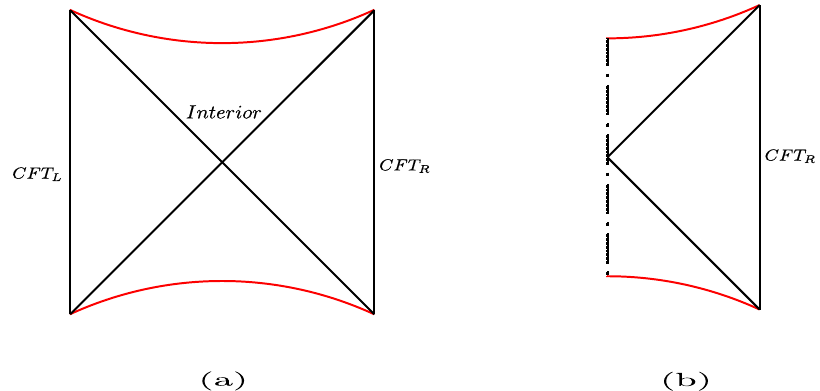
Figure 2 . ( a ) Penrose diagram of the eternal black hole and ( b ) the eternal black hole cut in half by an end of the world (ETW) brane (figure modified from that in